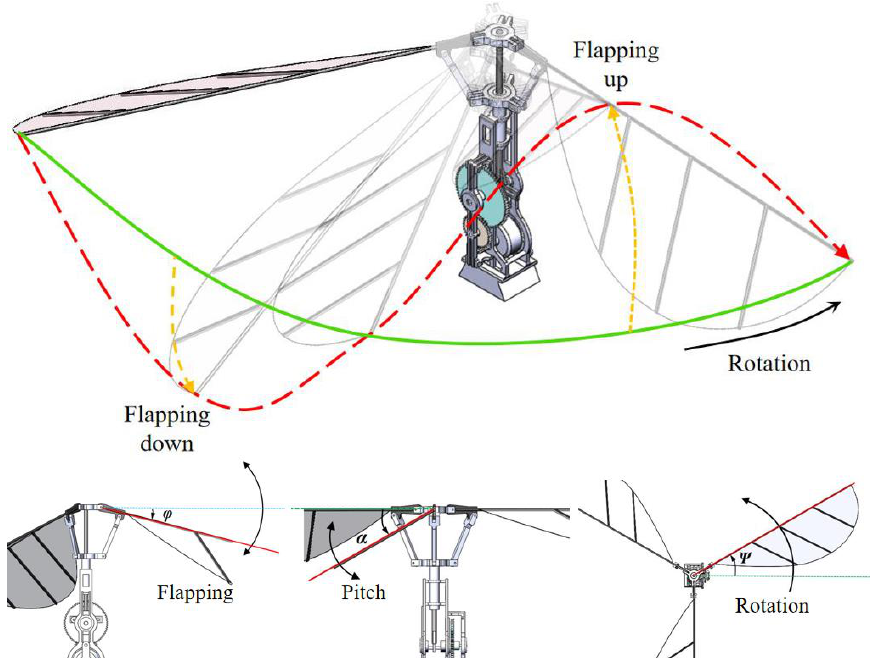
Figure 2. The lift generation system and the active flapping, passive rotation, and passive torsion of the wings.